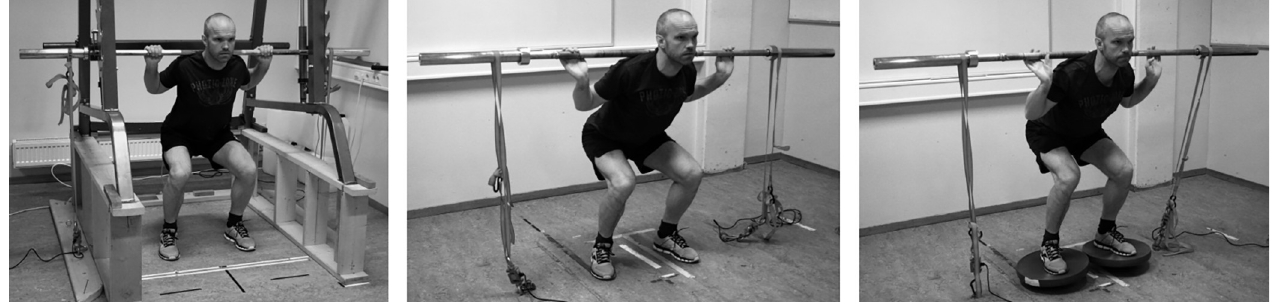
Fig 2. Testing procedures for the RFD, EMG and MVIC with low stability requirement, medium stability requirement and high stability requirement.